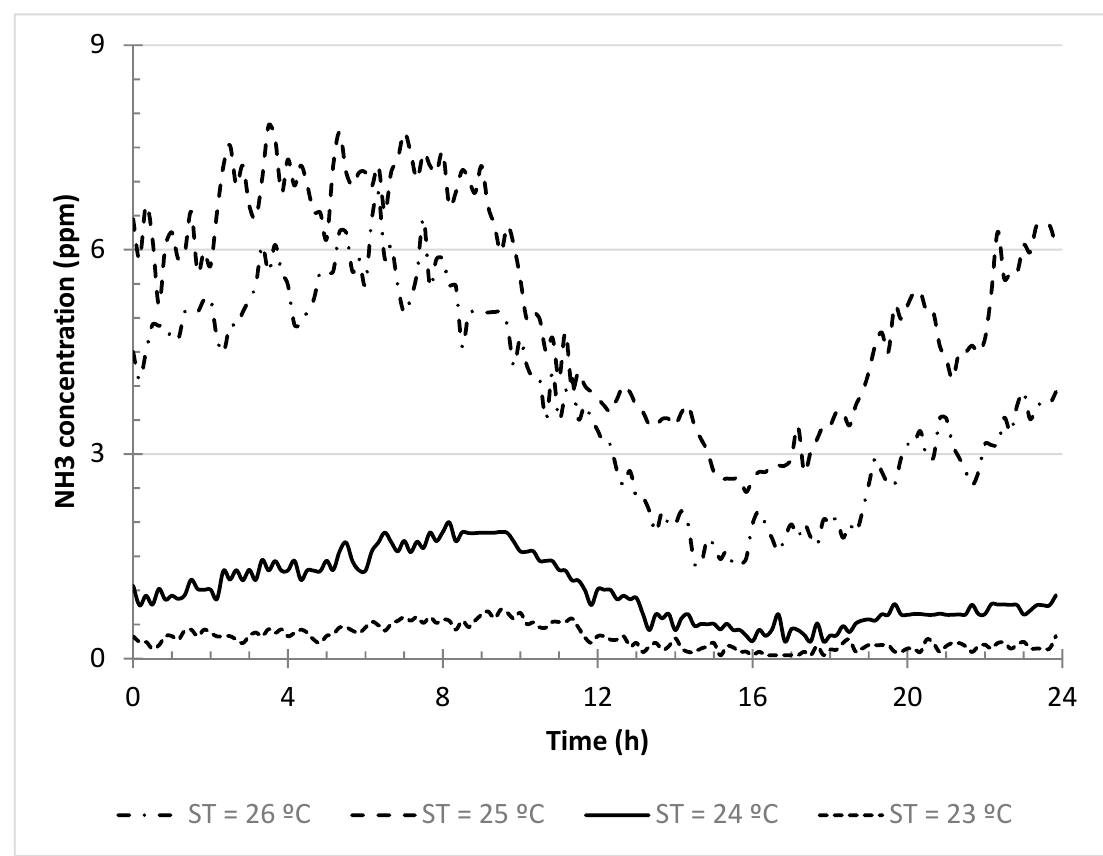
Figure 3. Daily evolution of average NH 3 concentration in the animal-occupied zone at 26, 25, 24, and 23 °C setpoint temperatures.